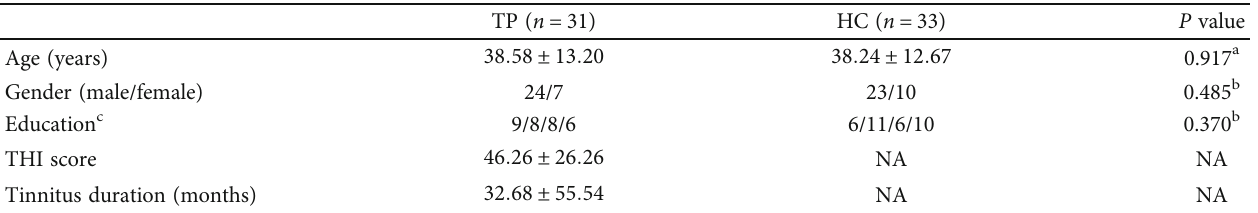
Figure 1: All subjects underwent single-sample t -tests of the DAN component obtained from ICA (FWE-corrected P < 0 : 001 ). The color bar indicates the t value of single-sample t -tests of two groups. Acronyms: DAN: dorsal attention network; ICA: independent component analysis; FWE: familywise error; L: left; R: right. Table 1: Demographic and clinical data of the tinnitus patients and healthy